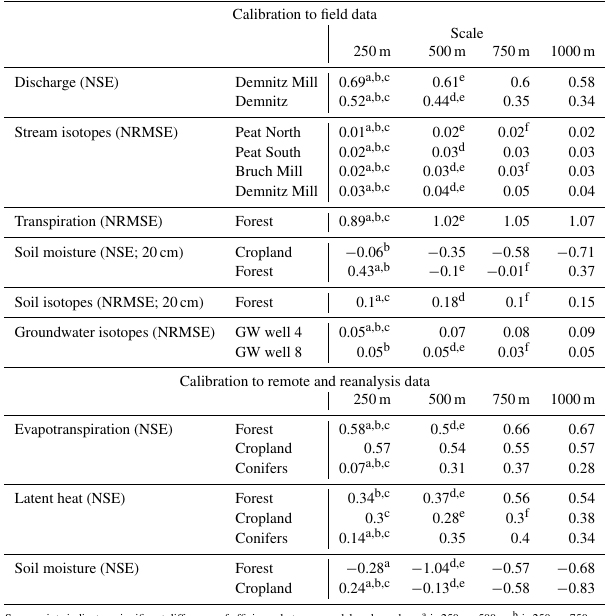
Table 4. Median model efficiency from multicriteria calibration (the brackets indicate the efficiency criteria).